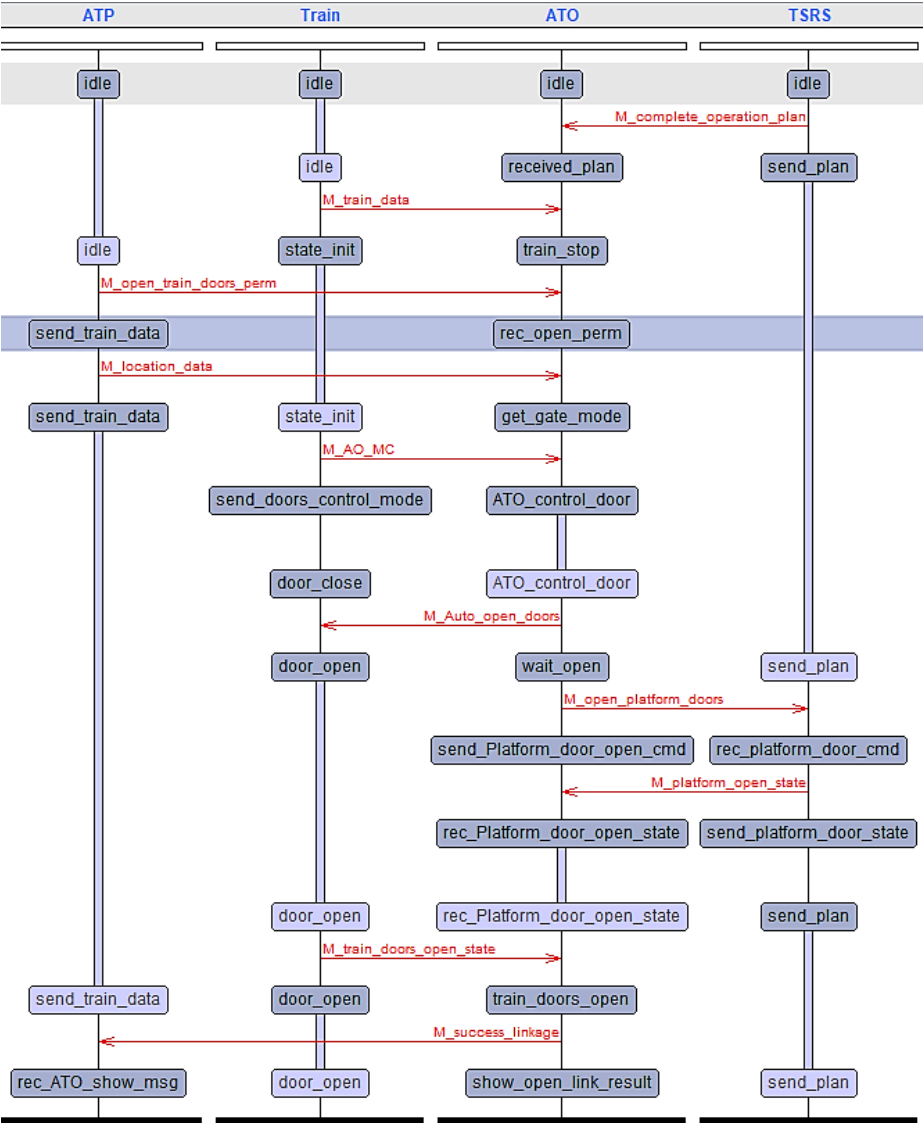
Figure 17. The verification diagram of the interaction